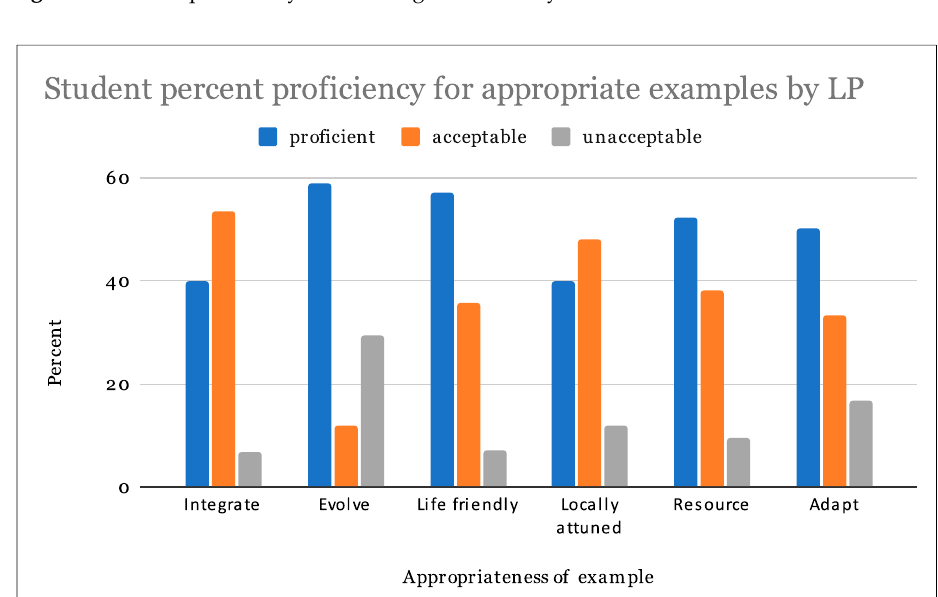
Figure 8. Student proficiency at choosing appropriate examples by LP.